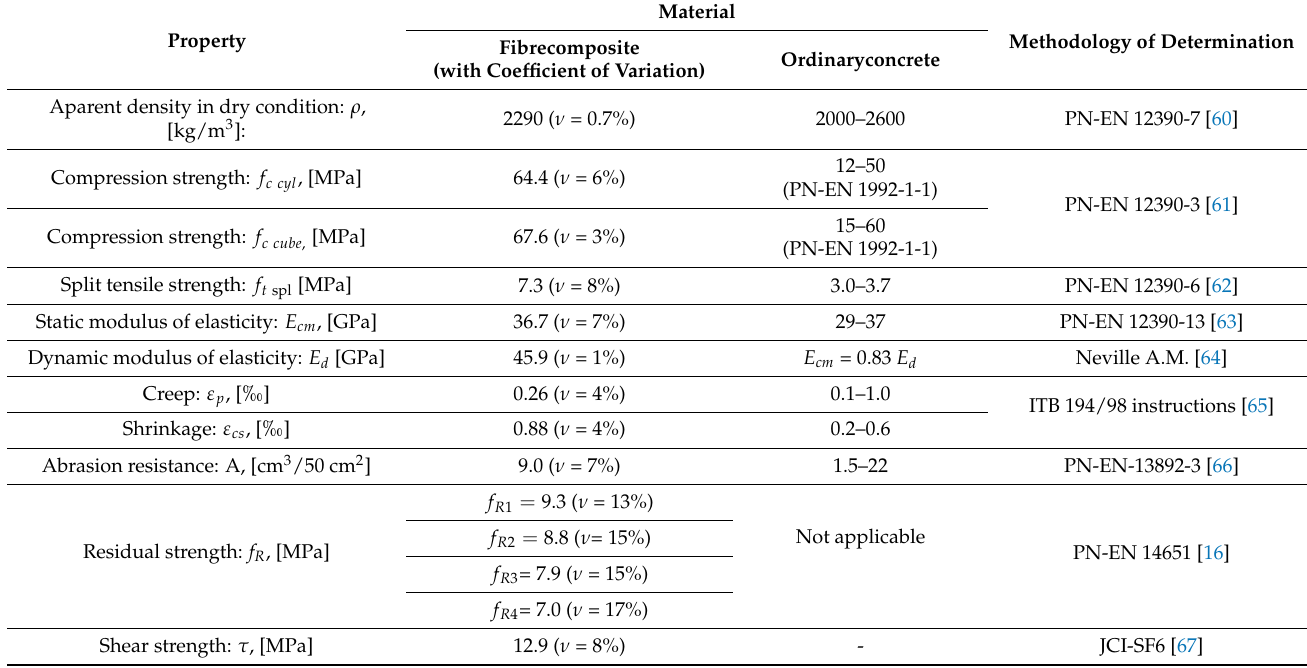
Table 2. Mechano-physical properties of the analysed fibre composite with ordinary concrete [12,14,51,59]. Material Property Methodology of DeterminationFibrecomposite (with Coefficient of